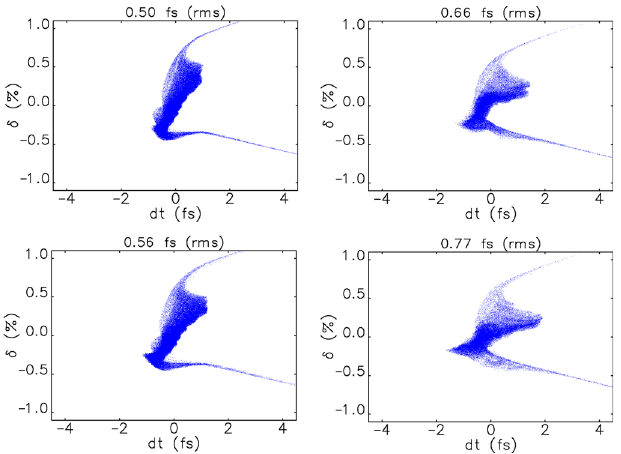
respectively.FIG. 8. Final longitudinal phase spaces simulated by IMPACT - T (left column) and CSRT rack (right column). The final vertical bunch sizes are about 54 μ m (upper row) and 21 μ m (lower row). The bunch charge is 2.7